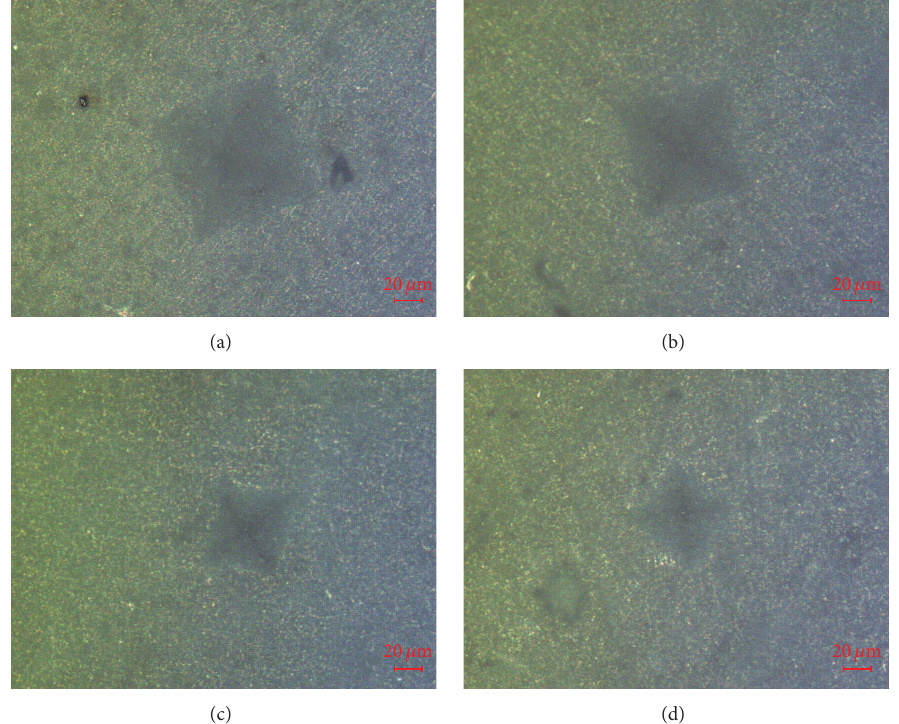
Figure 7: Optical microscope of the ZrO 2 ceramics with addition of 5wt% TiO 2 contents sintered at (a) 1150 ∘ C, (b) 1200 ∘ C, (c) 1250 ∘ C, and (d) 1300 ∘ C (the scale bar is 20 𝜇